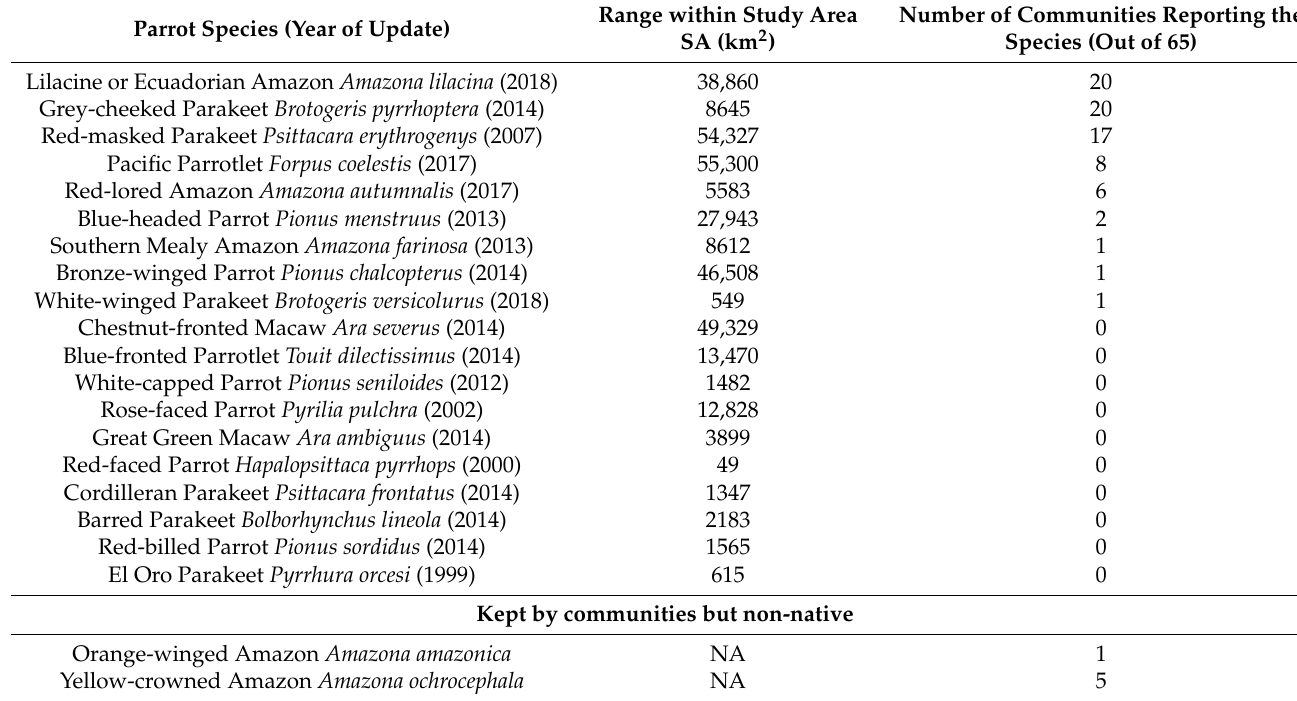
Figure 2. Examples of pet Lilacine Amazons in four rural communities in coastal Ecuador. Parrots were kept in a variety of situations; indoors or outdoors, caged or with clipped wings. In some cases pet parrots that were housed in gardens were not initially considered to be captive by the owner, but for the purposes of this study any parrot living in the locality of people was classed as a pet. Table 2. The number of communities in which each of the 19 species was reported as a pet and the range size within the study area according to BirdLife International [24].